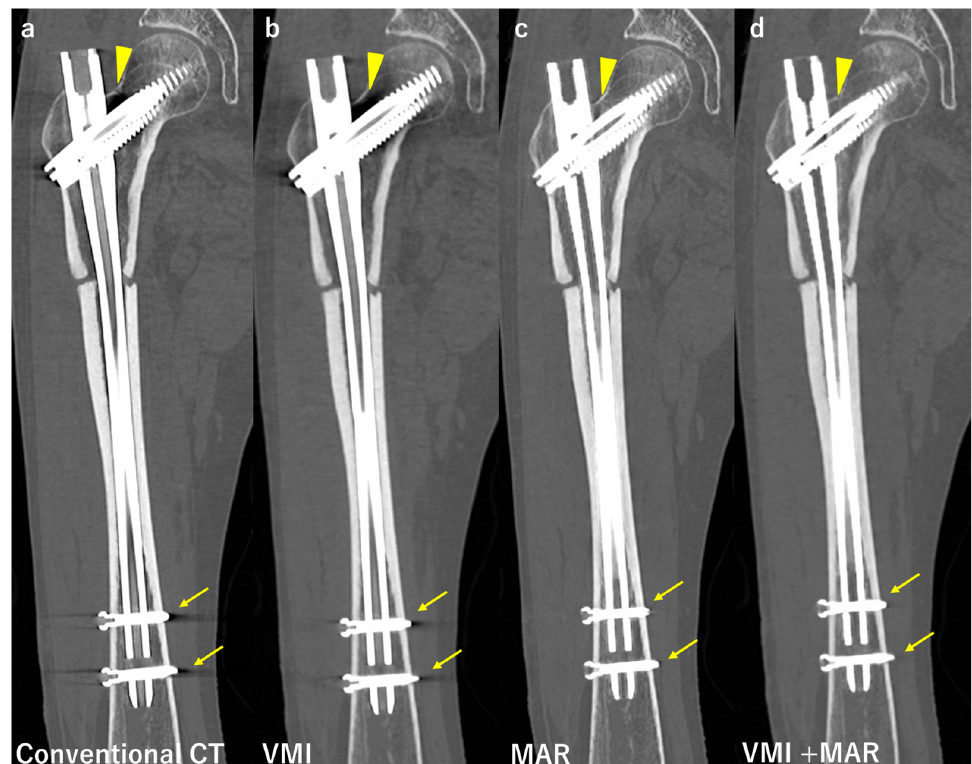
Figure 5. Comparison of conventional computed tomography (CT) and images reconstructed with virtual monoenergetic images (VMI), the metal artifact reduction algorithm (MAR), and combination of VMI and MAR. Coronal images of a patient after intramedullary nail fixation of the femur. Image ( a ) was taken by conventional CT at 120 kV, and shows strong beam hardening, scattering, photon starvation, and edge effects at the junction of the nail and lag screw (arrowheads), and at the tip of distal locking screws (arrows). Image ( b ) was taken by VMI at 135 kV, and the artifacts are slightly reduced, especially at the tip of distal locking screws. Image ( c ) was taken with MAR, and the artifact reduction is stronger than VMI, only very small dark streaks both at the junction of the nail and lag screw and at the tip of distal locking screws. Image ( d ) was taken in combination with VMI at 135 kV and MAR, and there are almost no artifacts present, leading to a better visualization of the outlines of the prosthesis.